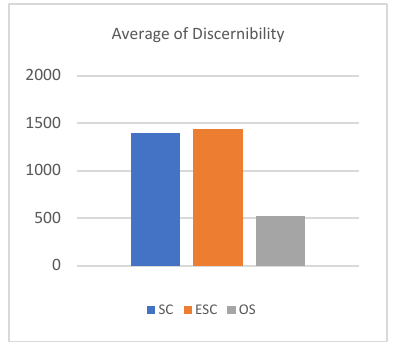
Figure 4. Average of discernibility Figure 3. Average of discernibility value.